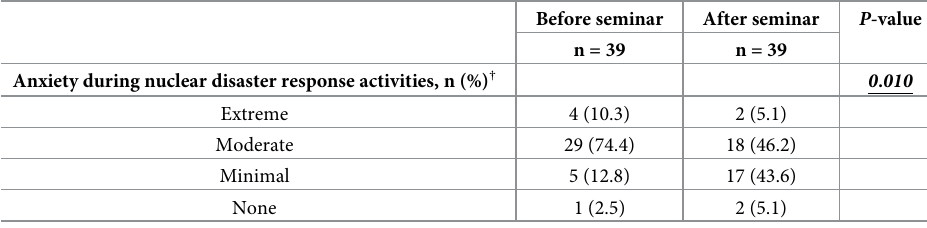
Table 4. Comparison of anxiety before and after attending the